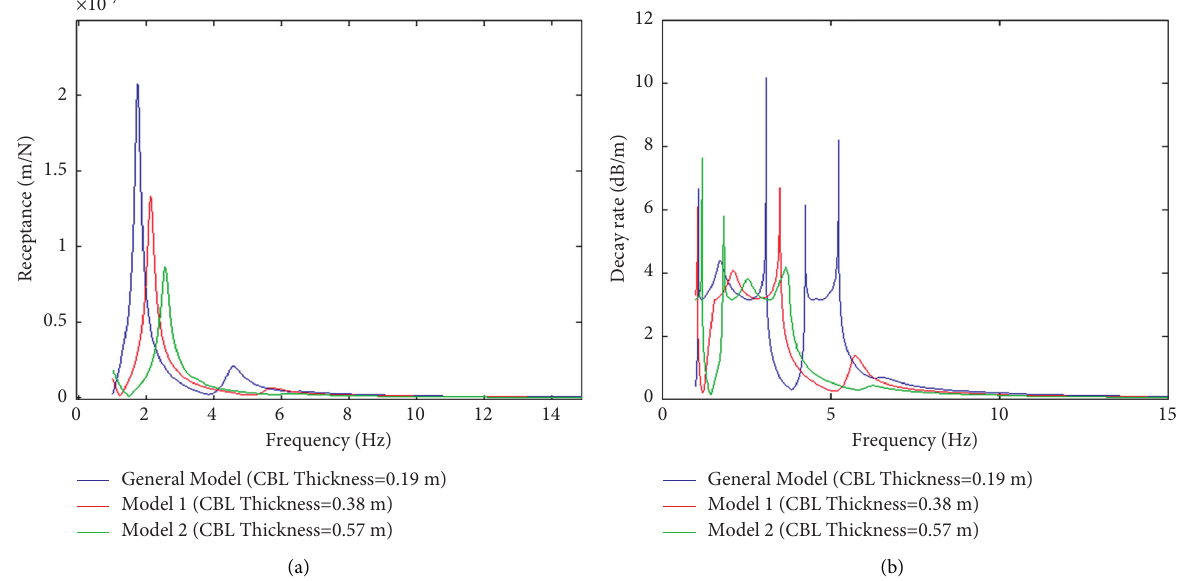
Figure 6: Effect of changes in the thickness of CBL on receptance and the decay rate: (a) effect of modulus on receptance and (b) effect of modulus on decay rate.